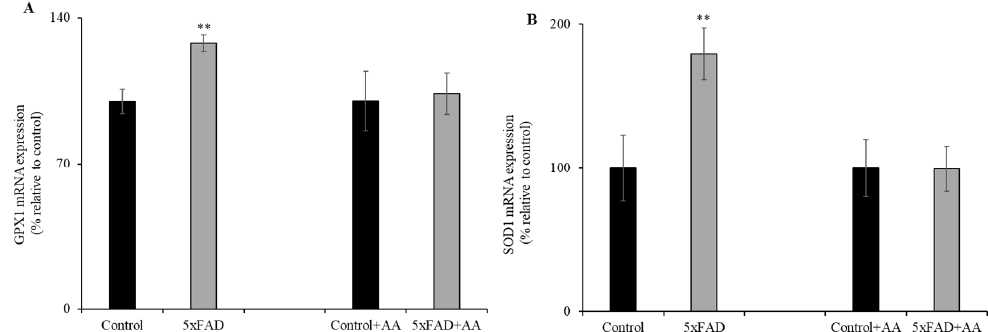
Figure 2. Levels of oxidative stress response genes expression in 5xFAD mice jejunum mucosa. RT ‐ qPCR from reverse ‐ transcribed total RNA of 5xFAD and WT littermate mice (maintained with and without vitamin C supplementation for 1 week) jejunum mucosal scraping was utilized to determine the mRNA expression levels of glutathione peroxidase 1 (GPX1) (A) and superoxide dismutase 1 (SOD1) (B). Values are means ± SE of at least four different mice ( n = 4). ** p < 0.05.